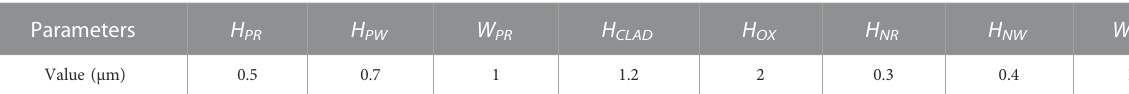
TABLE 2 The parameters of mode spot conventer. Parameters